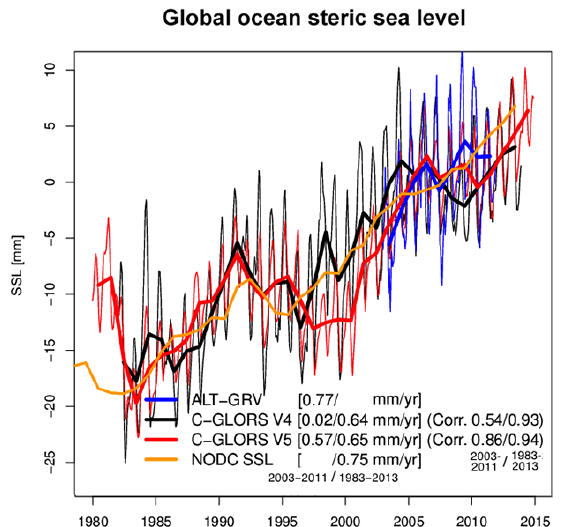
Figure 9. Global ocean steric sea level (SSL) (calculated over the top 2000m) for the reanalyses C-GLORSv4 and v5, along with esti- mates from satellite altimetry and gravimetry (ALT–GRV, Storto et al., 2016c) and NODC pentadal estimates (Levitus et al., 2012). The legend reports linear trends for the period 2003–2011 (for compari- son with ALT–GRV), and 1983–2013 (for comparison with NODC SSL and the temporal correlation against the two validating datasets during their respective period. Correlations are statistically signifi- cant if greater than 0.25 and 0.46 at 99% confidence level, based on bootstrapping, for the 2003–2011 monthly data and the 1983–2013 yearly data validation, respectively.